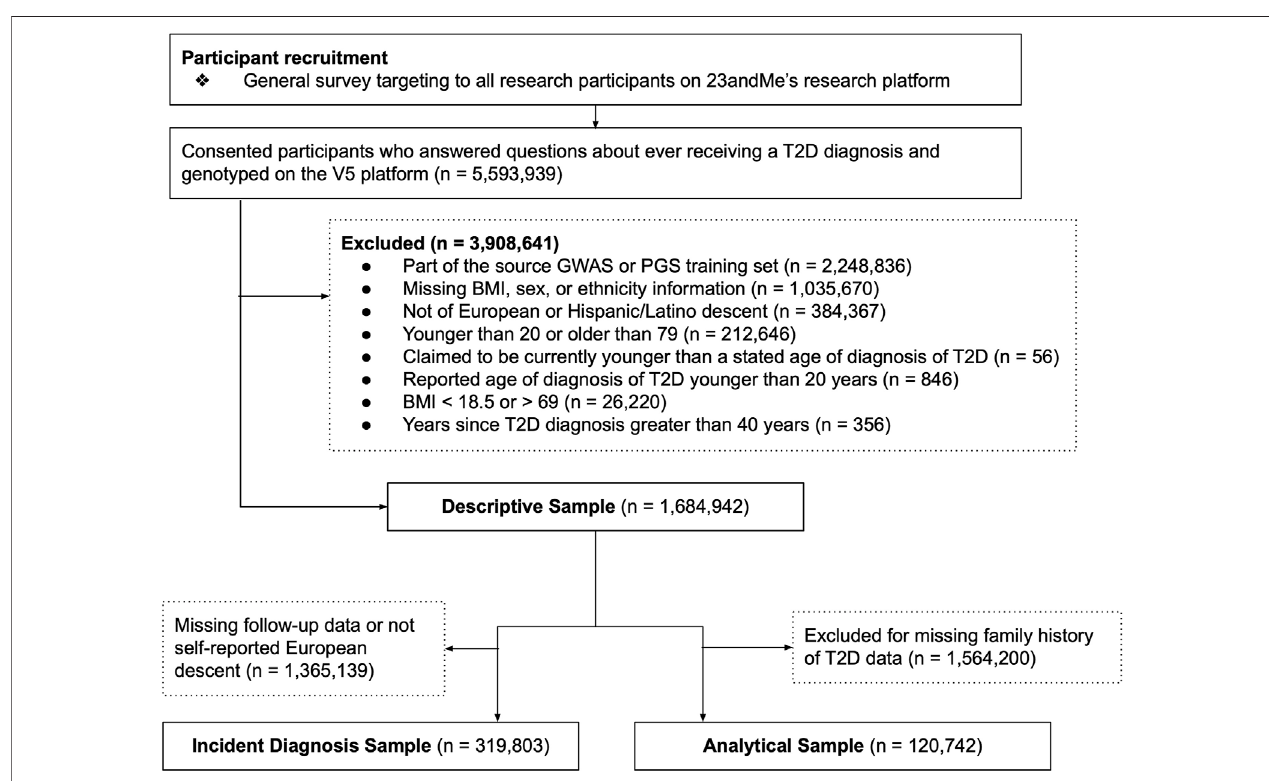
FIGURE 1 | Participant recruitment and analysis fl ow diagram. Three data sets were used for components of this analysis. The Descriptive Sample was used to generate plots, to estimate raw prevalences, or to estimate unadjusted odds ratios. The Incident Diagnosis Sample was used to assess the association between the polygenicscore(PGS) andincidentdiagnosisover time.TheAnalyticalSamplewasused forregressionmodels thatincluded family historyasapredictor.Sub-sampling was required due to missing data in key survey questions required for analysis, and participant attrition over time.